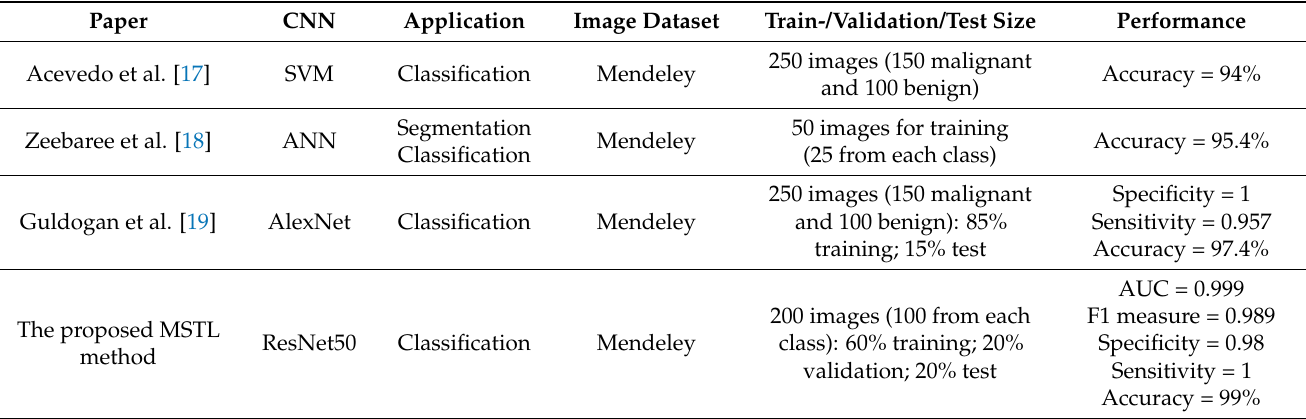
Table 2. Comparison of the proposed multistage transfer learning method with state-of-the-art ultrasound breast cancer classification methods. SVM: support vector machine; ANN: artificial neural network; AUC: area under ROC